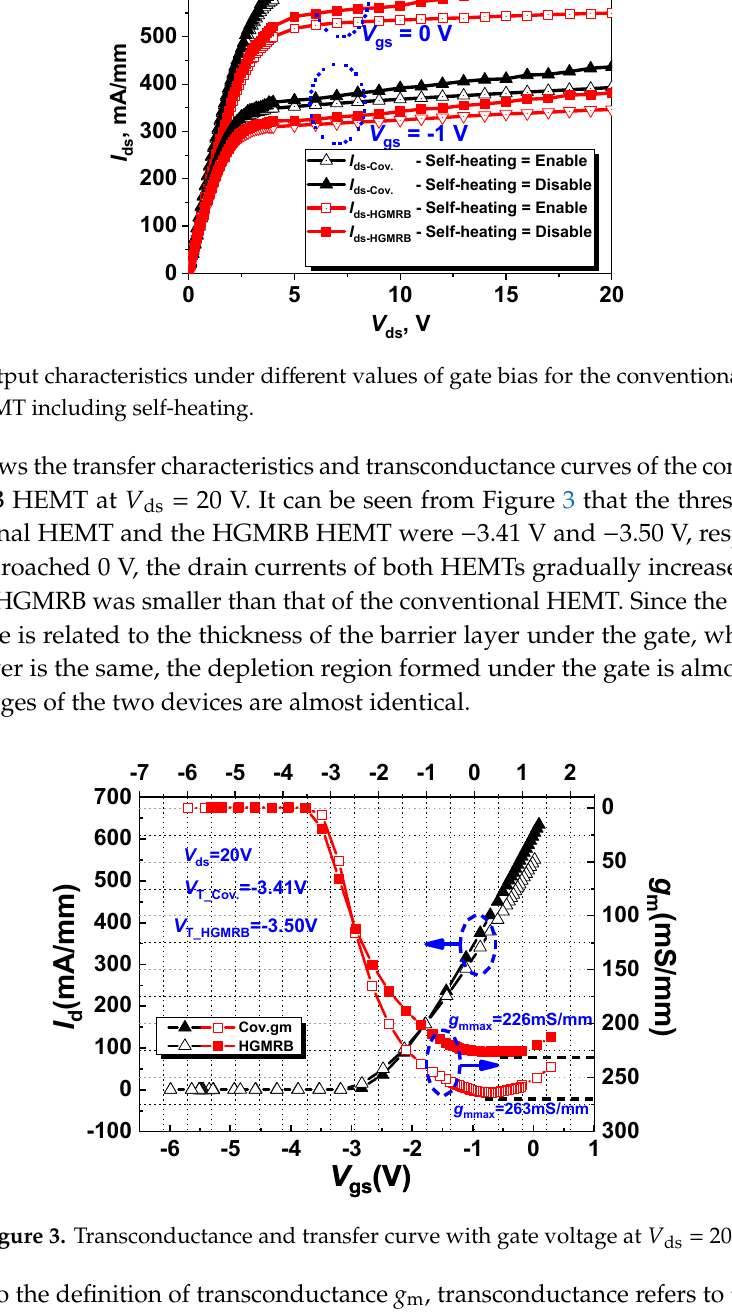
Figure 2. Output characteristics under different values of gate bias for the conventional HEMT and HGMRB HEMT including self-heating.